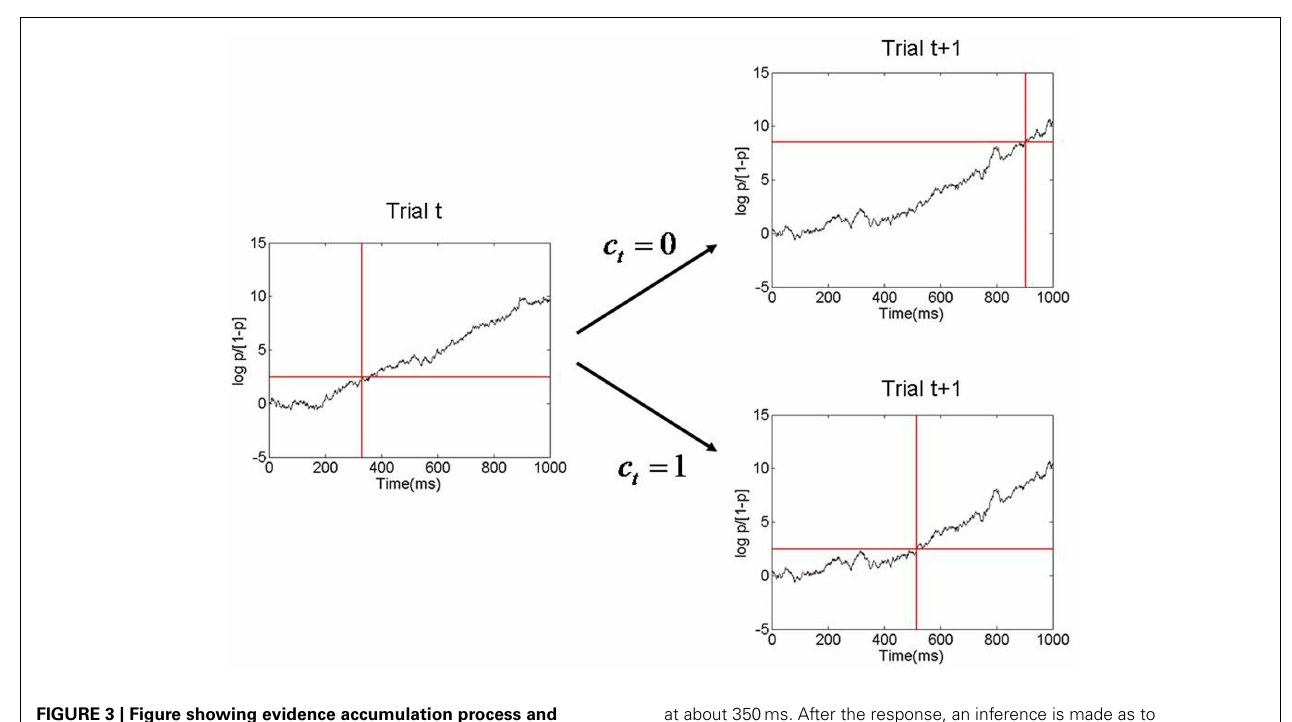
FIGURE 3 | Figure showing evidence accumulation process and how the decision threshold is changed from one trial to the next . Here p is the probability of pressing the right button and log p /[1 − p ] is the corresponding log odds ratio. In this example the decision threshold has a low value on trial t , corresponding to p = β [1]. Evidence is accumulated and a response is made when the threshold is reached,